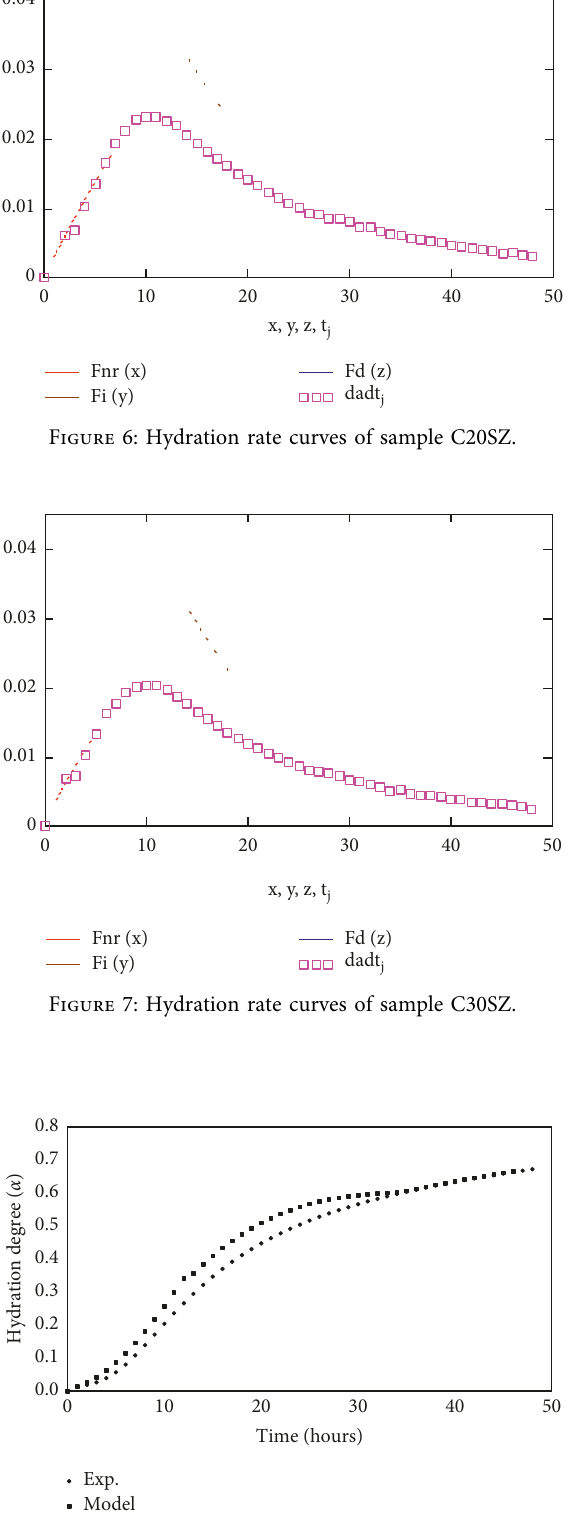
Figure 8: Experimental results of the hydration degree with the assumed kinetic model for sample C.